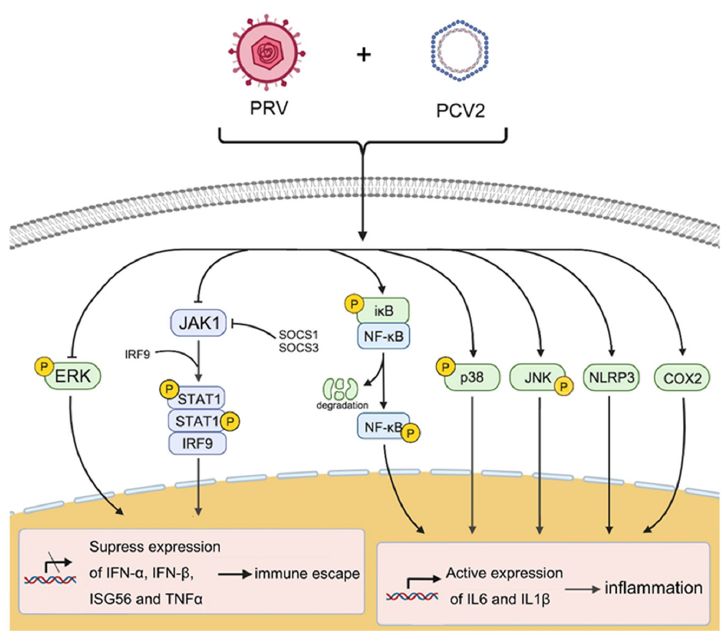
Figure 9. Proposed immune and inflammatory reactions caused by coinfection of PCV2 and PRV. Arrow ( → ), enhance; T line ( ⊥ ) means